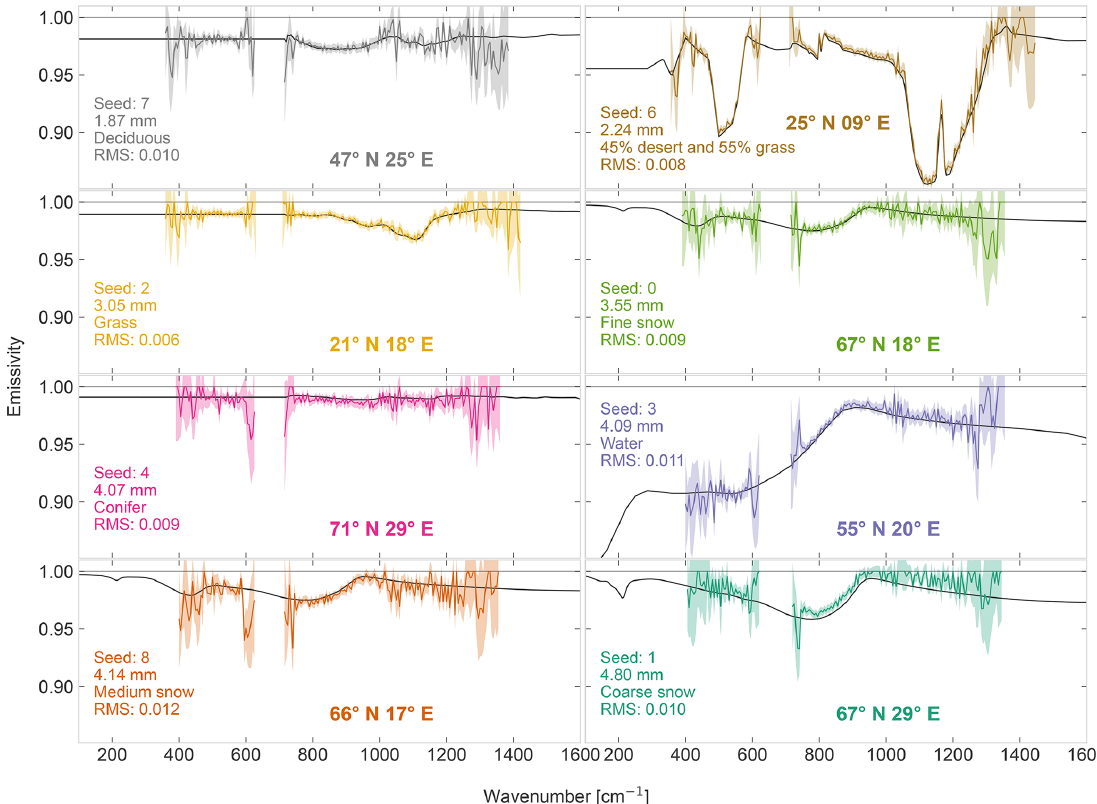
Figure 5. Retrieved emissivity for eight scenes with various surface types. The retrieved emissivity is shown as a dark coloured line, with the 1 σ retrieval uncertainty range shown as a shaded region of the same colour. The true emissivity is shown as a solid black line in each figure, and the a priori emissivity is in grey. All retrievals use the baseline parameters from Sect. 3. Each scene uses atmospheric and surface data from the coordinates indicated on the figure for 15 January 2018 at 12:00UTC. More information for each scene is listed in Table 1, and the true precipitable water vapour content and surface type is indicated on the figures. Each retrieval uses synthetic observations generated with a different random instrumental noise seed to mirror true retrieval conditions, and the seed is indicated on the corresponding figure. The retrieved emissivity is only shown in the spectral regions in which the information quantifier (see Eq. 5) is larger than 1, and the indicated root mean square error (RMS) is calculated in these